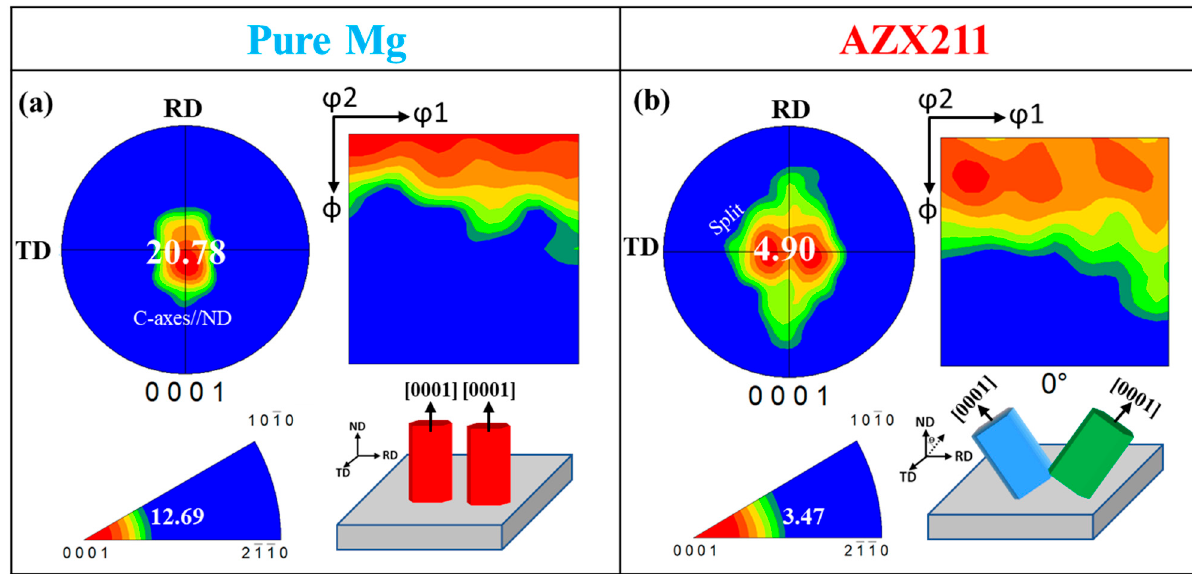
Figure 3. ( a ) SEM showing the precipitates distributed in the matrix, ( b ) OM, ( c ) EDS and ( d – f ) elemental mapping of Al, Ca, and Zn distributed in the AZX211. Table 1. EDS elemental analysis of